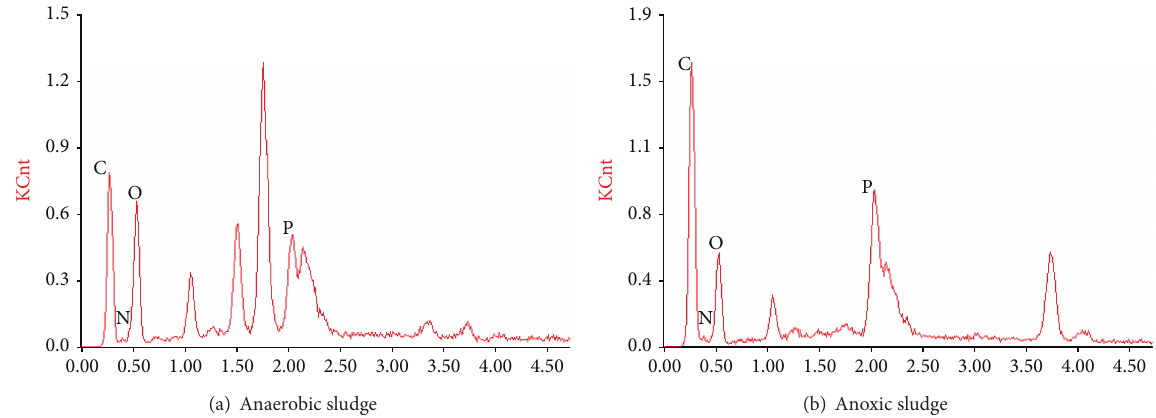
Figure 3: Analytical X-ray spectrum of anaerobic sludge and anoxic sludge in two-sludge DPB process, where the spectrum was given with energies of these X-rays (KeV) as abscissa and specific counts of each specific energy as vertical coordinates (KCnt).